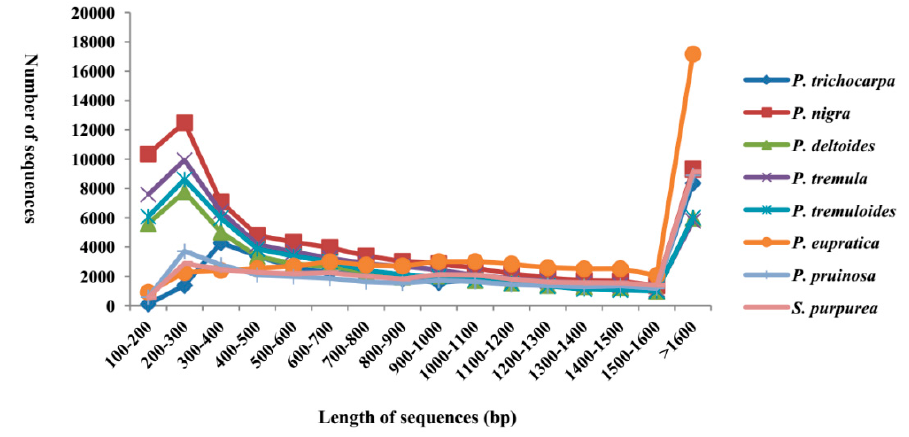
Figure 1. Distribution of coding sequences (CDS) length of eight Salicaceae species. 102